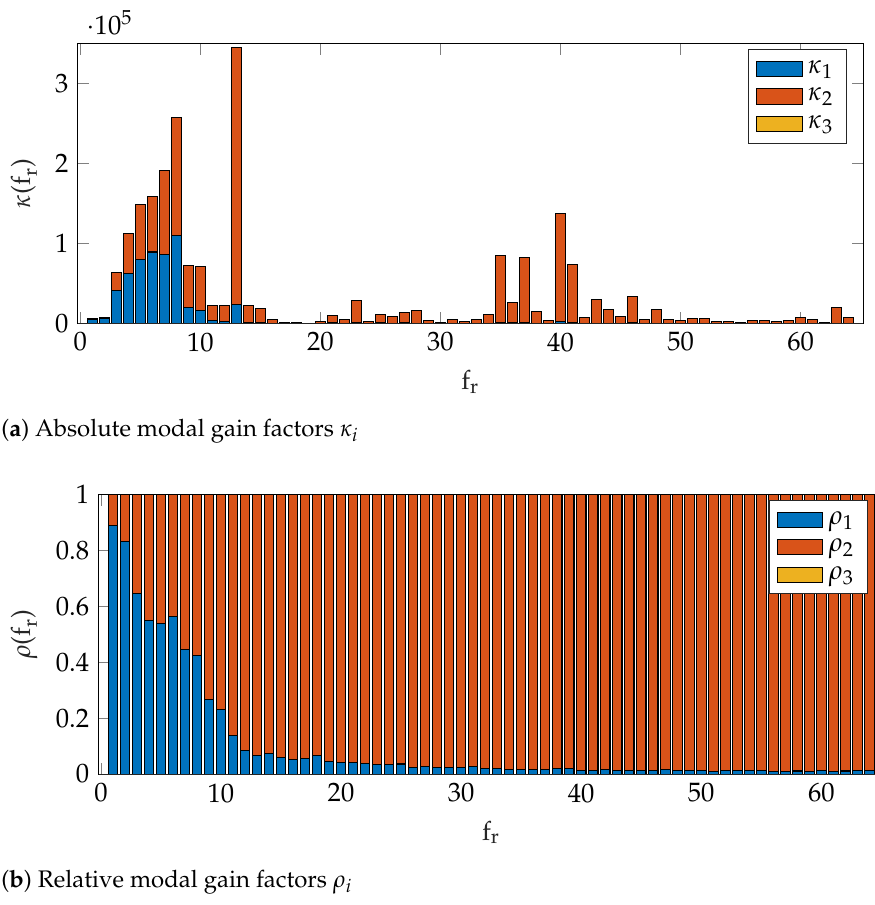
Figure 10. Modal gain factors for modes #1 - #64